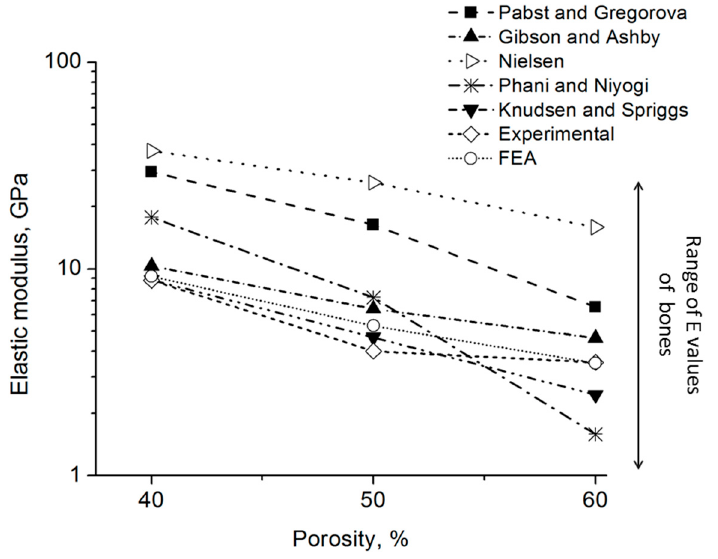
Figure 9. Estimation of E value using different models and experimental data.